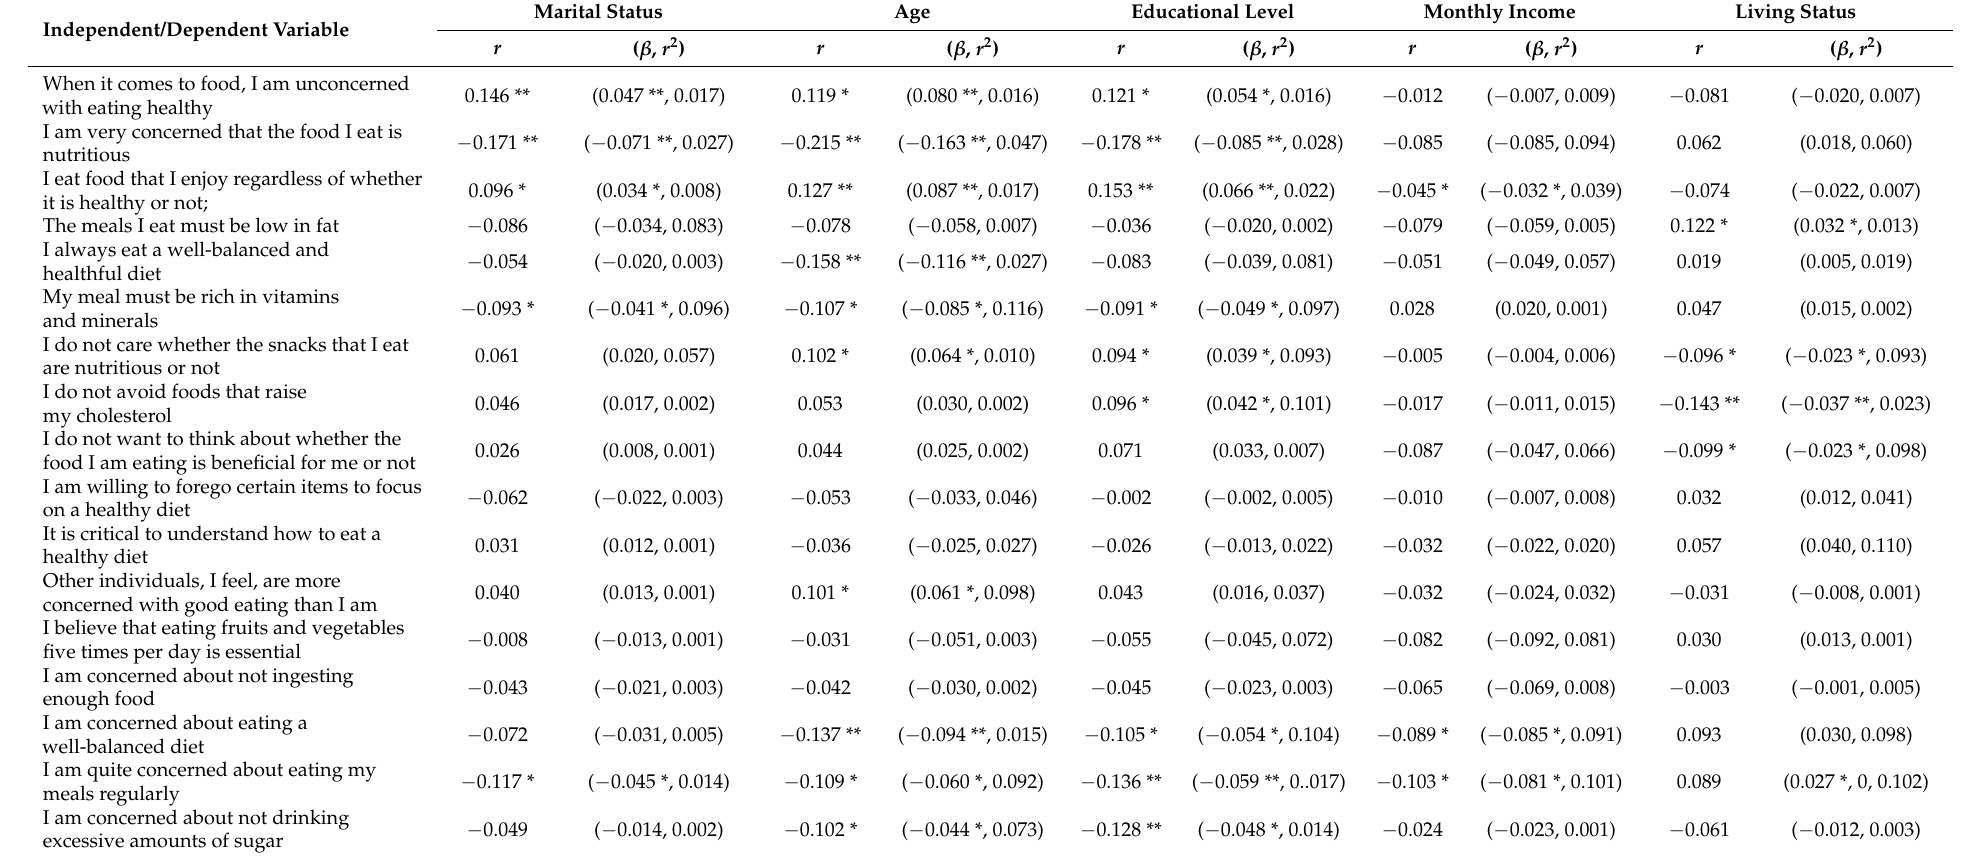
Table 7. Spearman correlation coefficients ( r ) and simple linear regression analysis ( β , r 2 ) between demographic characteristics and food policy awareness after calorie labeling for females ( n =